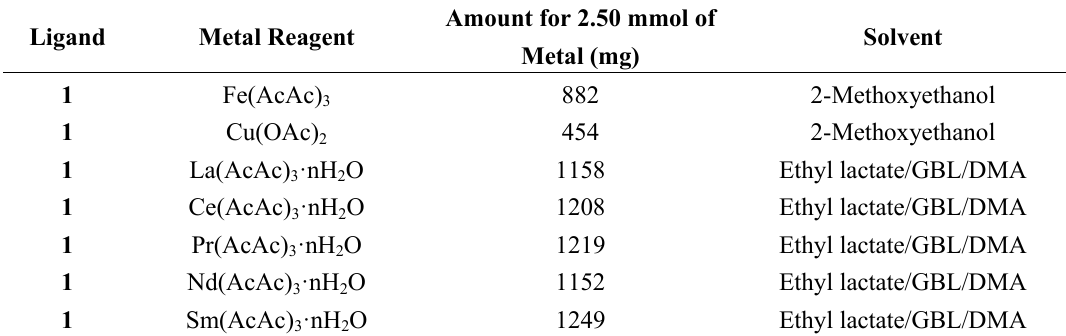
Table 4. Photo-reactive metal complex coating solution